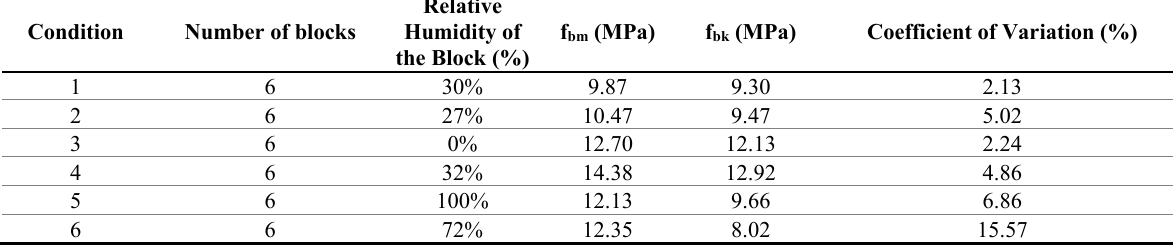
Table 3. Results obtained for group B blocks.